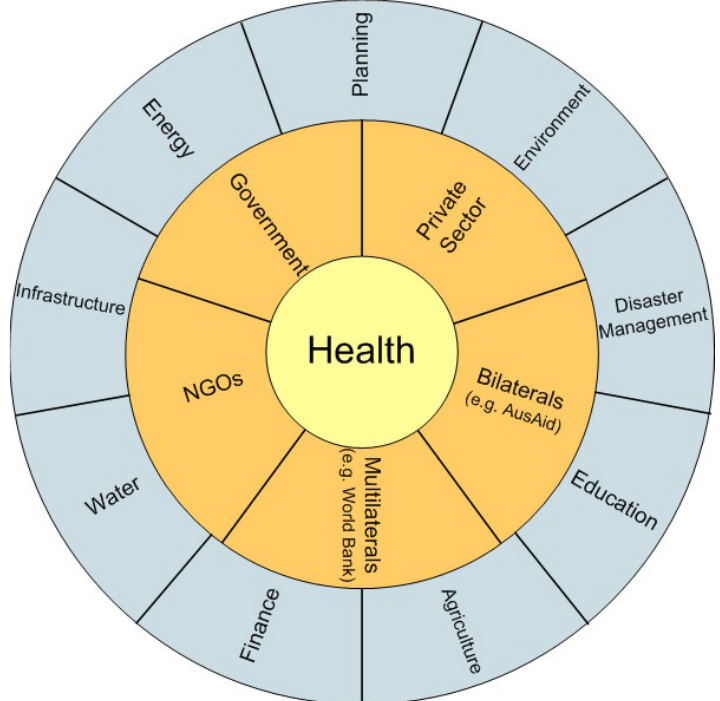
Figure 3. Integrated view of institutions and sectors all relevant to the health effects of climate